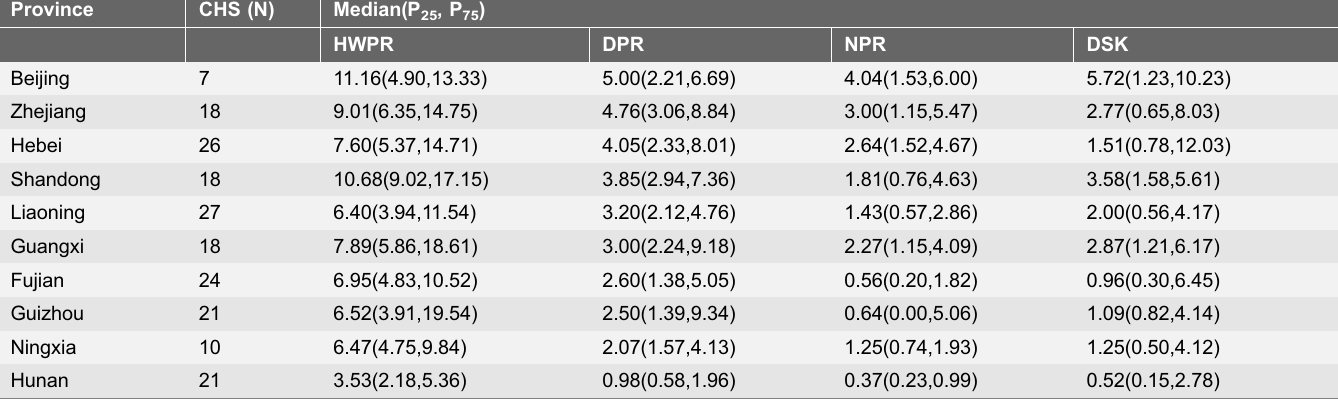
Table 1. Health workforce per 10000 population ratio or per square kilometer in each province (n 5